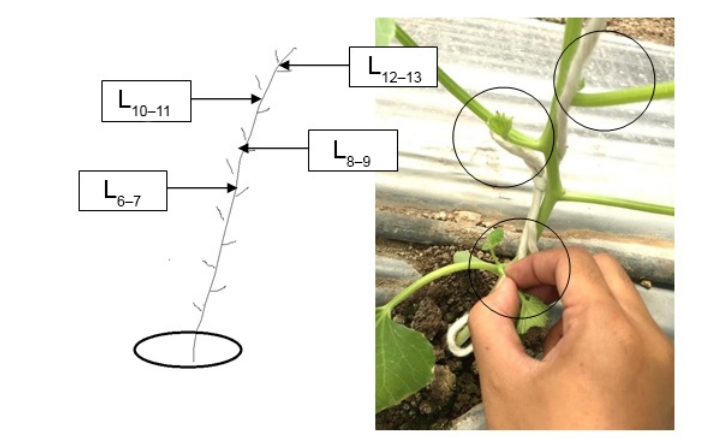
Figure 2 Arranging the position of melon fruit and trimming lateral